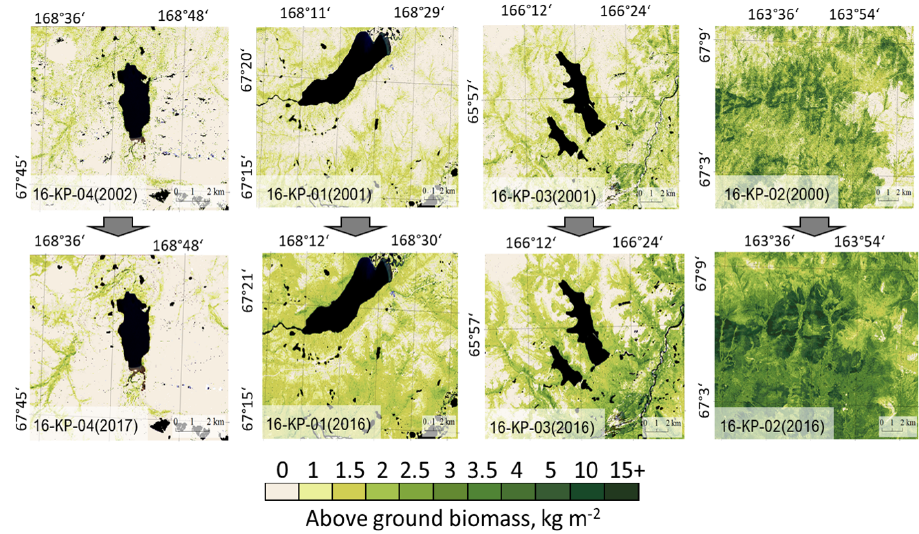
Figure 8. Landsat-derived maps of total above-ground biomass (AGB) in historical years (2000, 2001, or 2002) and recent years (2016 or 2017) in four focus areas: treeless tundra (16-KP-04), northern tundra–taiga (16-KP-01), southern tundra–taiga (16-KP-03), and northern taiga (16-KP-770